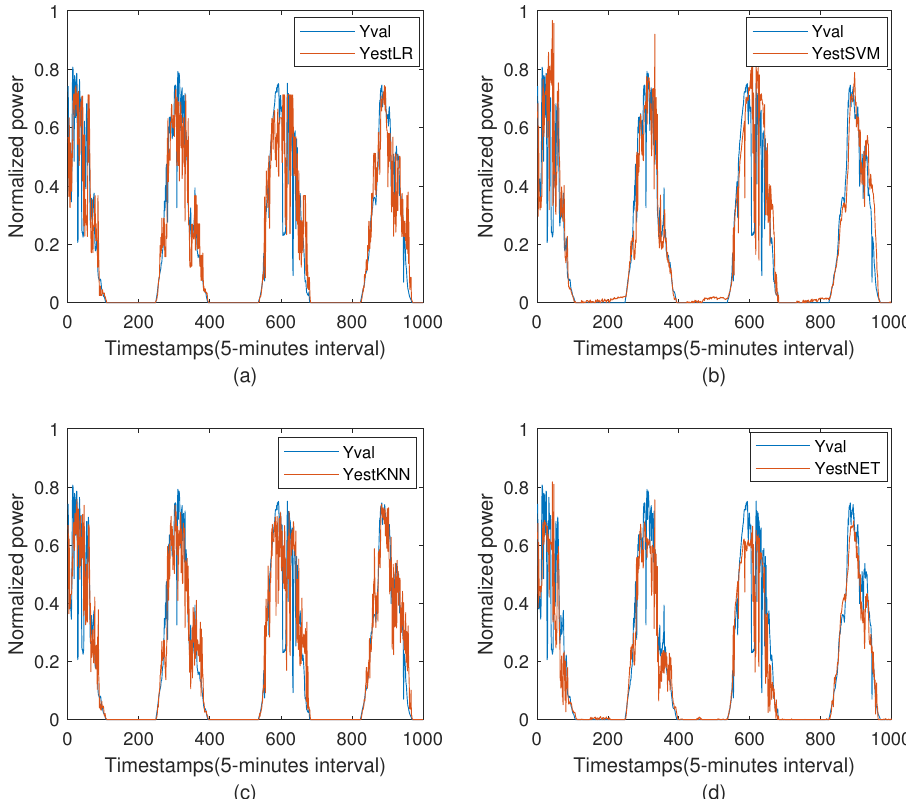
Figure 8. A 1000 sample graph of actual PV power data (blue) versus the estimation with each one of the techniques (orange): Linear Regression ( a ); Support Vector Machines ( b ); K-Nearest Neighbors ( c ); and Artificial Neural Networks ( d